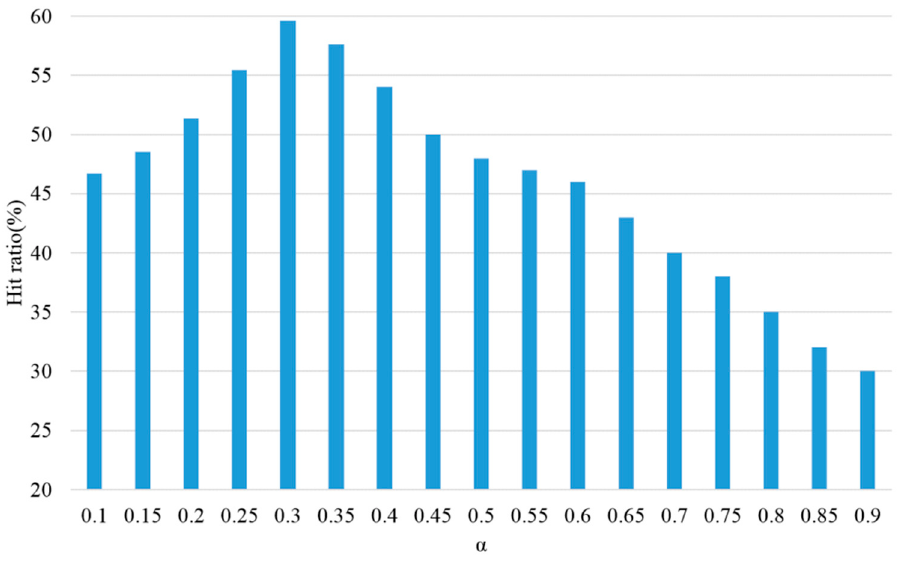
Figure 9. Hit ratio according to α value.